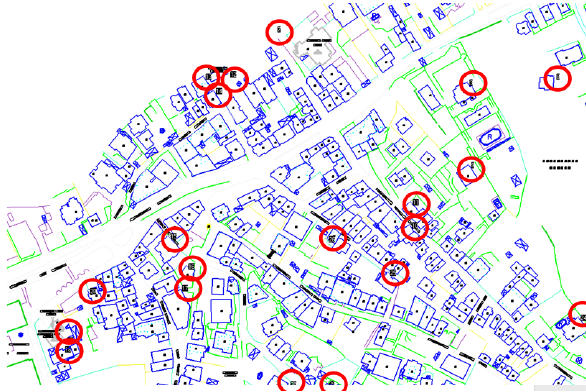
Figure 3. The distribution of the control points in the 1:1000 scaled digital